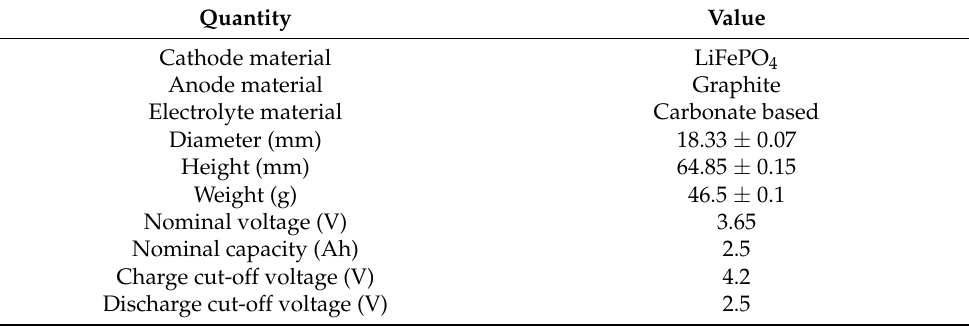
Table 1. Materials and physical parameters of lithium-ion battery.